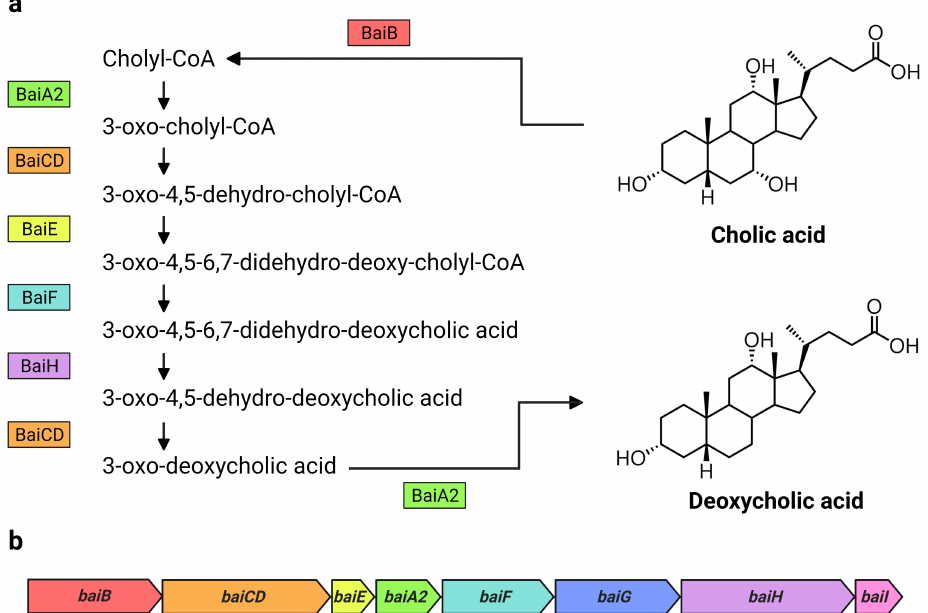
Figure 1. Bai proteins and bai genes involved in the formation of DCA from CA. Overview of ( a ) the 7 α -dehydroxylation of CA to DCA including Bai proteins and intermediate products in C. scindens VPI 12708, as proposed by Funabashi et al. [14], and ( b ) the arrangement of the bai operon in C. scindens VPI 12708 and ATCC 35704 T [2]. Bai proteins are color coded with their respective genes in the bai operon. Figure created with